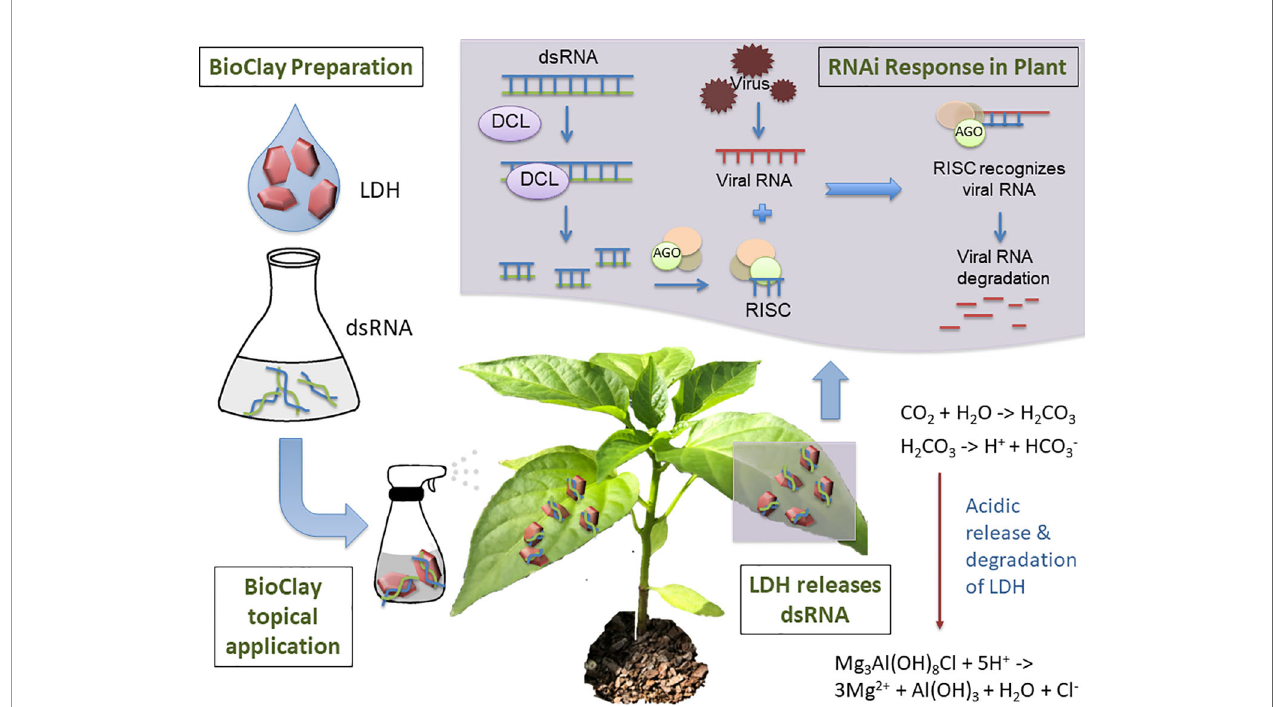
FIGURE 1 | Topical application of BioClay allows for extended RNAi-mediated protection from plant viruses. BioClay is a complex of double-stranded RNA (dsRNA) and layered double hydroxide (LDH). BioClay is prepared by mixing dsRNA and LDH in solution and is applied as a foliar spray. Moisture and carbon dioxide combine to allow acid release of the dsRNA, with LDH degrading to its constituents. The dsRNA can subsequently be taken up by the plant and prime its RNA machinery to degrade homologous viral RNAs. Due to the stabilization and slow release of dsRNA, resistance to the target virus relative to naked dsRNA can be extended from days to